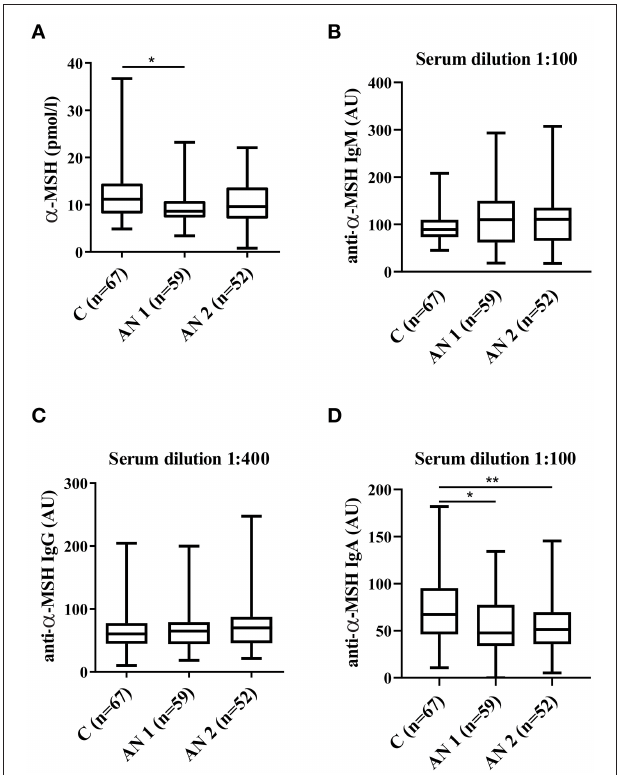
FIGURE 1 | Alpha-melanocyte stimulating hormone ( α -MSH) levels. (A) α -MSH levels in healthy controls, patients at hospital admission (AN1) and their discharge (AN2). (B–D) Levels of anti- α -MSH antibodies (IgM, IgG, and IgA, respectively). * p < 0.05, ** p <